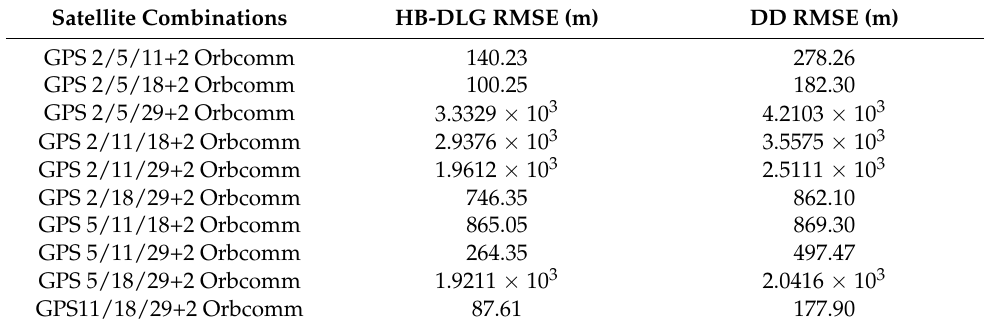
Table 2. RMSE of the baseline error under single-epoch of HB-DLG and DD algorithms. Satellite Combinations